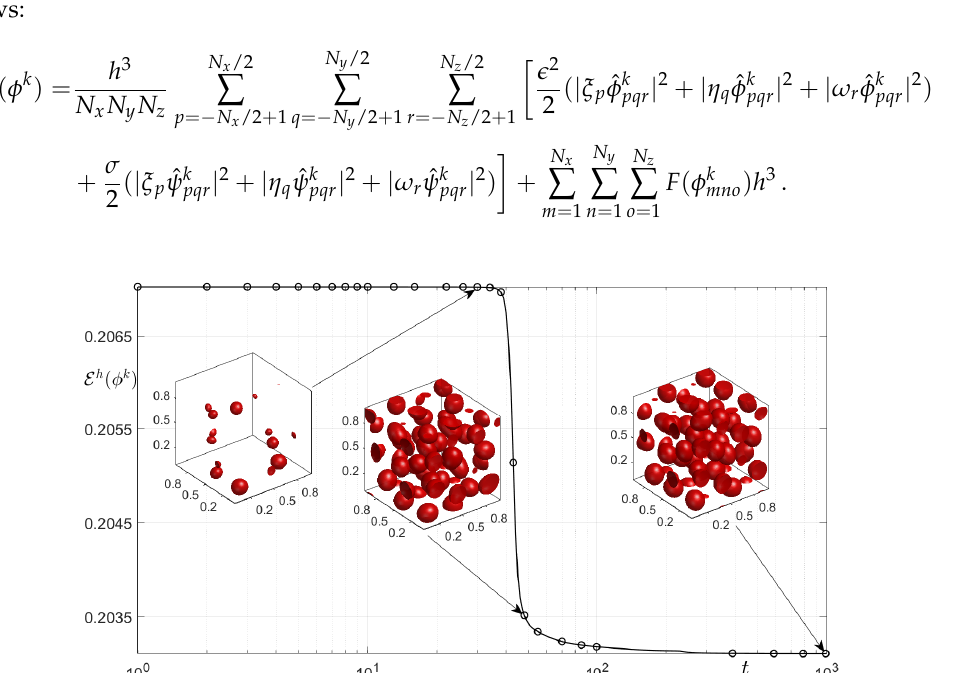
Figure 32. Energy dissipation over time of Equation (85) via nonlocal CH equation with the initial condition (84) . Each snapshot depicts the evolution at t = 400 ∆ t , 700 ∆ t , and 10,000 ∆ t , respectively. Note that t -axis is on